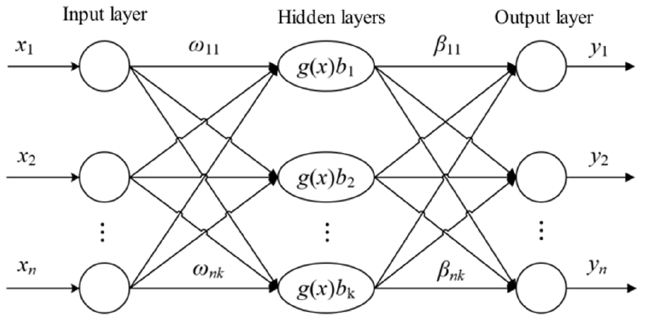
Figure 4. Extreme learning machine network model.